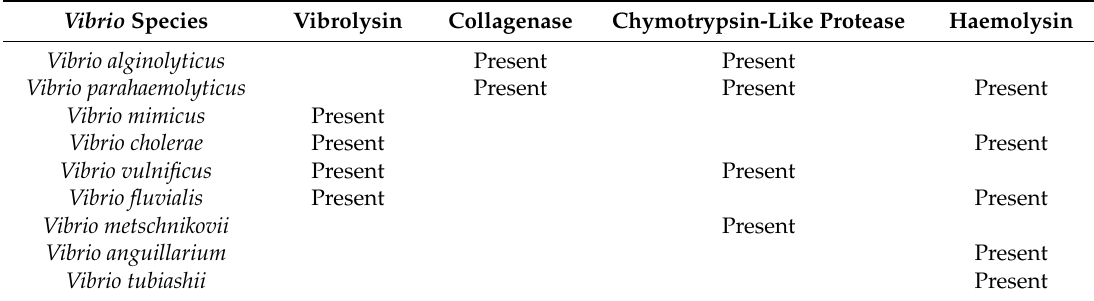
Table 3. Some proteolytic enzymes produced by pathogenic Vibrio species. Adapted from [49,123]. Vibrio Species Vibrolysin Collagenase Chymotrypsin-Like Protease Haemolysin Vibrio alginolyticus Present Present Present Present Present Present